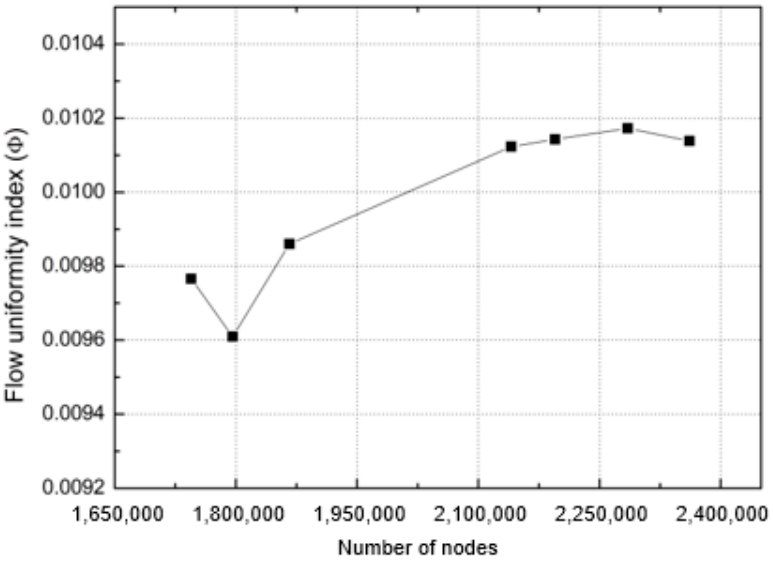
Figure 3. Comparison of flow non-uniformity index for di ff erent numbers of nodes.